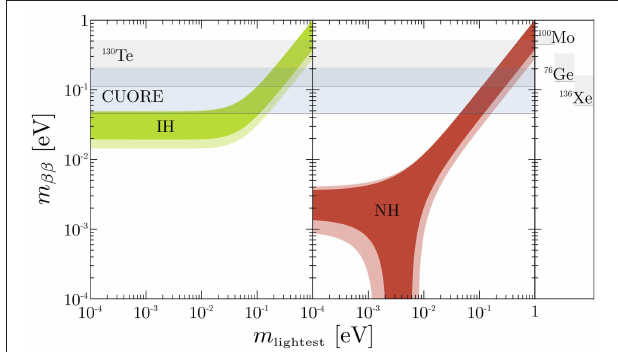
FIGURE 7 | Predictions on m ββ from oscillations as a function of the mass of the lightest neutrino in the two cases of NH and IH. The shaded areas correspond to the 3 σ regions after propagation of the uncertainties on the oscillation parameters [87]. The horizontal gray band shows the current 0 νββ limit of 130 Te after the first CUORE data release [ 69], while the blue band shows the projected CUORE sensitivity [ 81]. To the side, the current limits on the 0 νββ half-life for 76 Ge [80], 100 Mo [88] and 136 Xe [79] are reported.